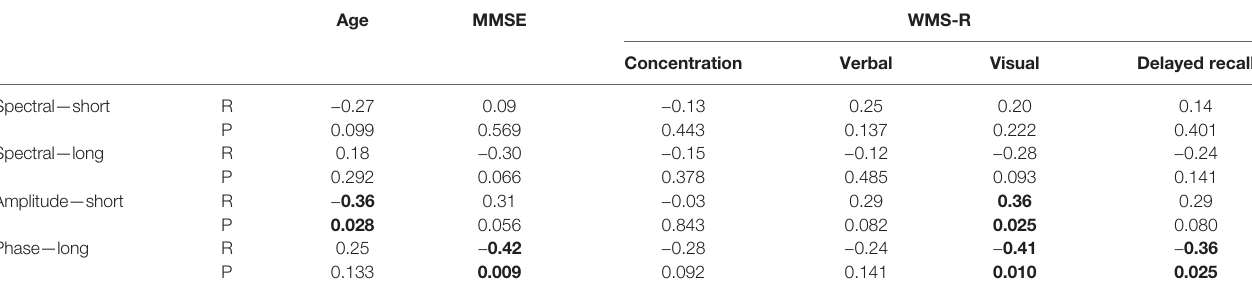
WMS-R Concentration Verbal Visual Delayed